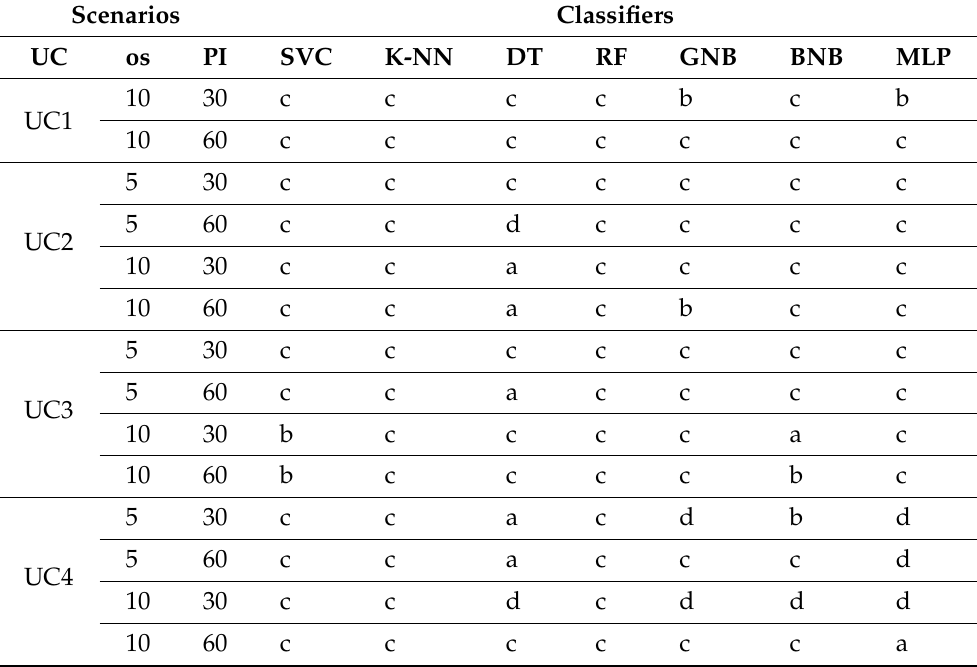
Table 1. Decision criteria with maximum accuracy evaluated accross different scenarios and classifiers (a = Belief score, b = Plausibility score, c = Pignistic score, d = GBT score). The detailed scores are available in the attached supplementary